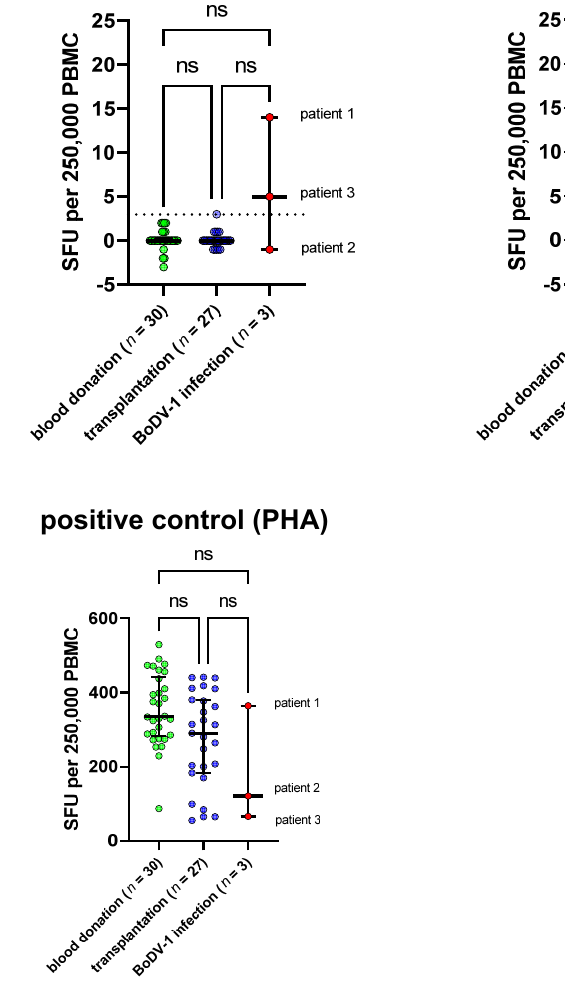
Figure 1. Spot counts of BoDV-1 ELISpot. PBMC samples of three patients with BoDV-1 infection were of sufficient viability to be stimulated with peptide pools comprising either the BoDV-1 N, X or P protein (15-mer peptides with an overlap of 11aa). Patient 2 and patient 3 were under immunosuppressive treatment at the time of sampling. PBMC cultivated in medium only served as the negative control, PBMC stimulated with phytohemagglutinin (PHA) as the positive control. Counts of matched negative controls were subtracted from other conditions for further analysis. For the negative control, the uncorrected counts are shown. In comparison, healthy blood donors ( n = 30) and patients after solid-organ transplantation ( n = 27) were tested. Spot forming units (SFU) are shown for the seeded 250,000 PBMC. Lines represent the median with interquartile range (IQR). SFU counts of patients with BoDV-1 infection were significantly elevated for stimulation with the N peptide pool based on a Kruskal-Wallis test followed by Dunn’s multiple comparisons test (ns p > 0.05; * p ≤ 0.05; ** p ≤ 0.01). Dotted horizontal lines represent the calculated cut-offs for stimulation with each peptide pool, based on the data of blood donation (mean + 3 standard deviations).